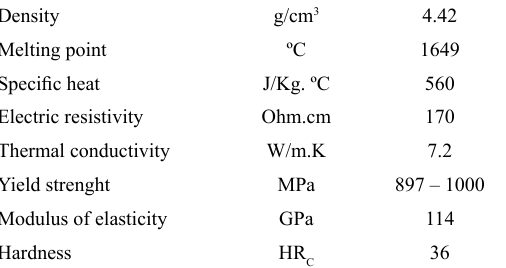
Table 1. Physical and mechanical propertis of Ti6Al4V.